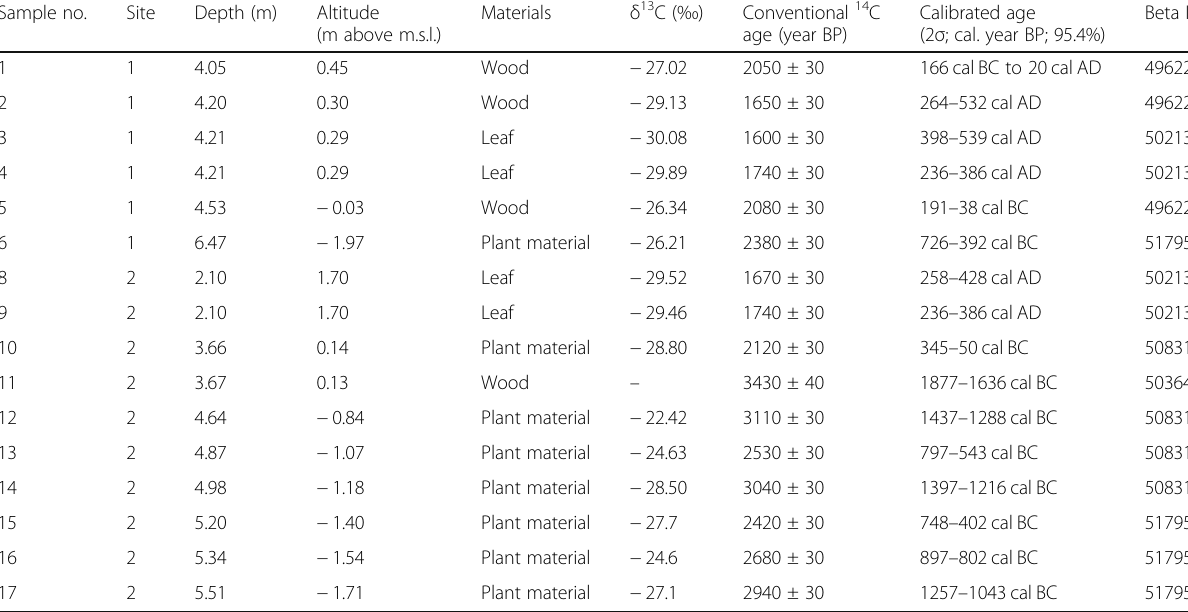
Table 1 14 C ages of samples from the study area Sample